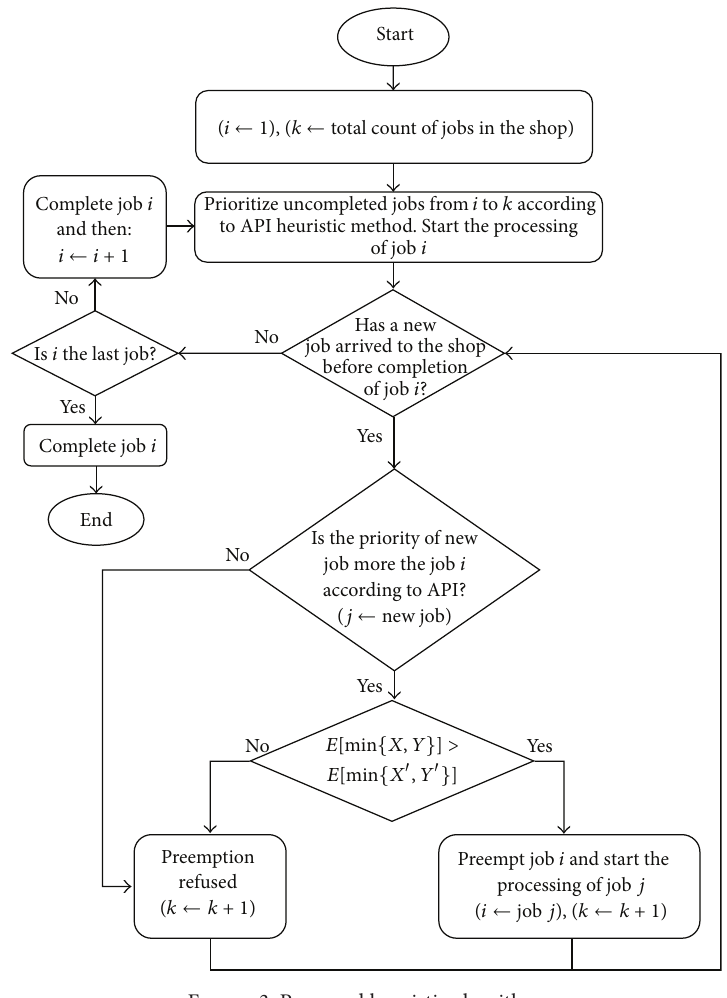
Figure 3: Proposed heuristic